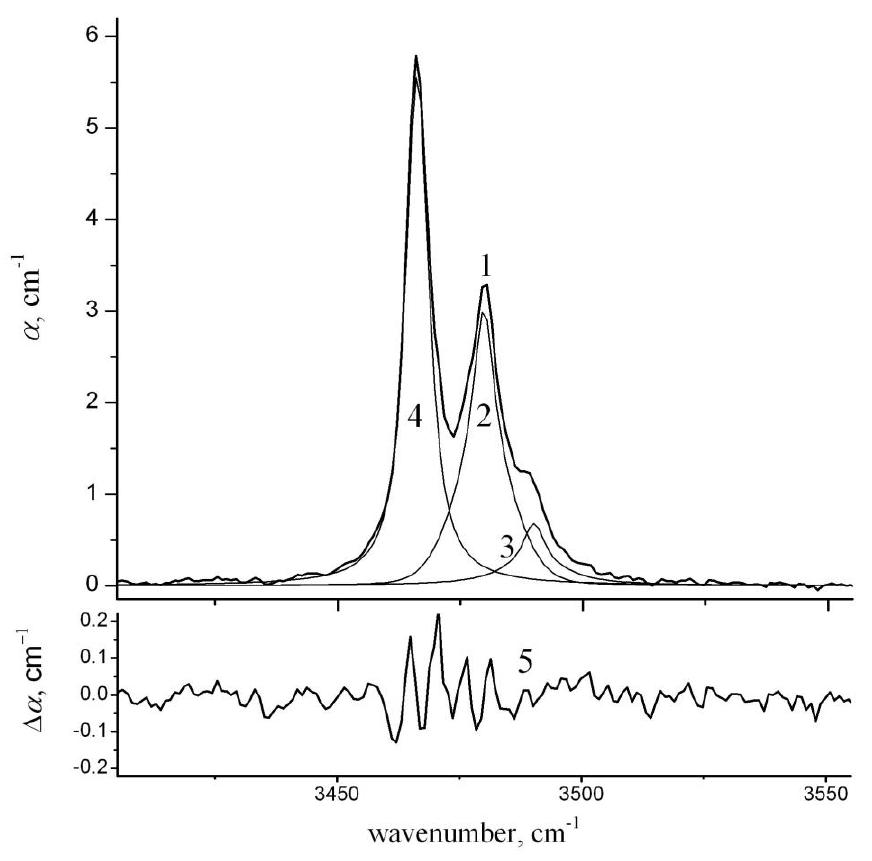
Figure 7. IR spectrum of NSLN2: (1) integrated IR absorption spectrum of the NSLN2 sample; (2) – (4) spectrum components; and (5) difference function Δ α .